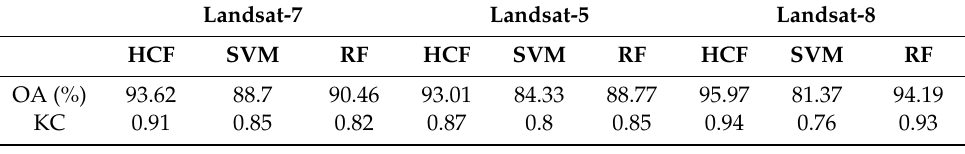
Table 4. Classification accuracies from HCF, SVM and RF on the Yellow river estuary Landsat data.